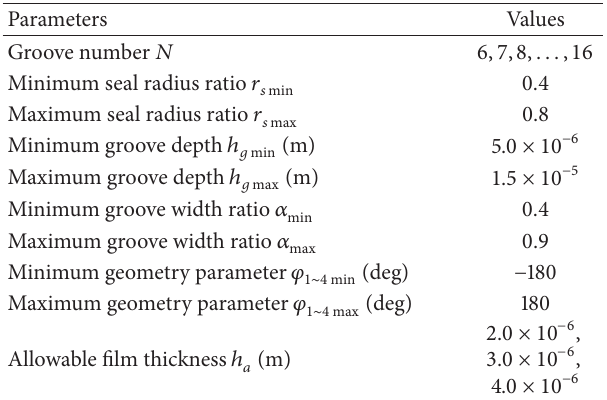
Table 2: Prescribed constraint